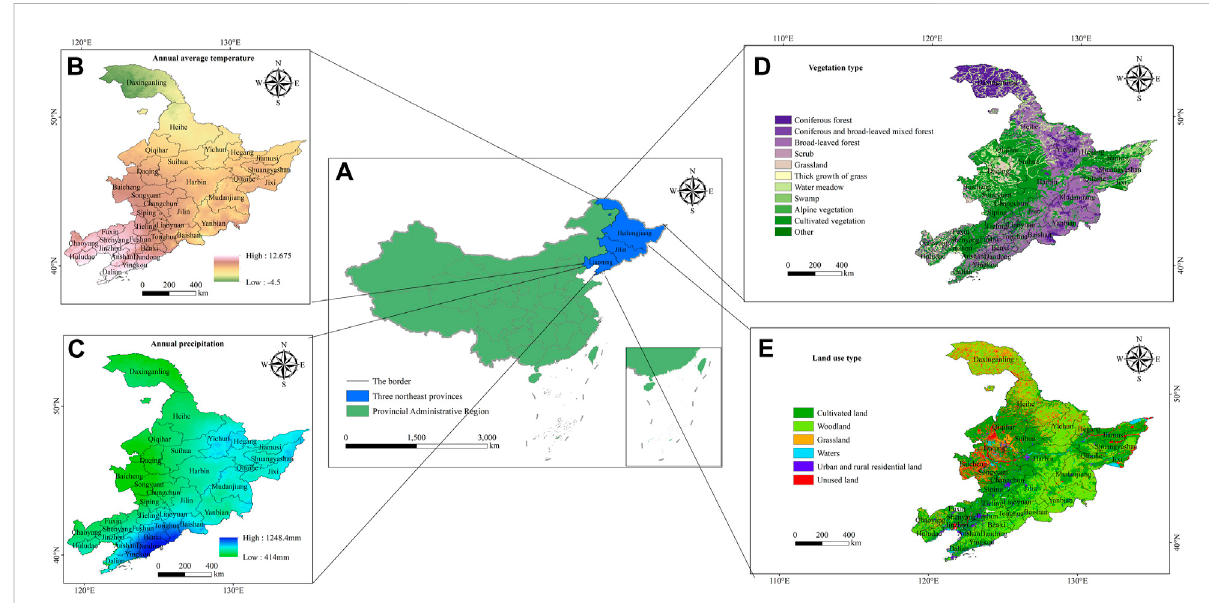
FIGURE 1 Mapofthestudyarea (A) :Locationmapofthestudyarea; (B) annualaveragetemperaturemapofthestudyarea; (C) annualprecipitationmapof the study area; (D) vegetation type map of the study area; (E) land use type map of the study area).